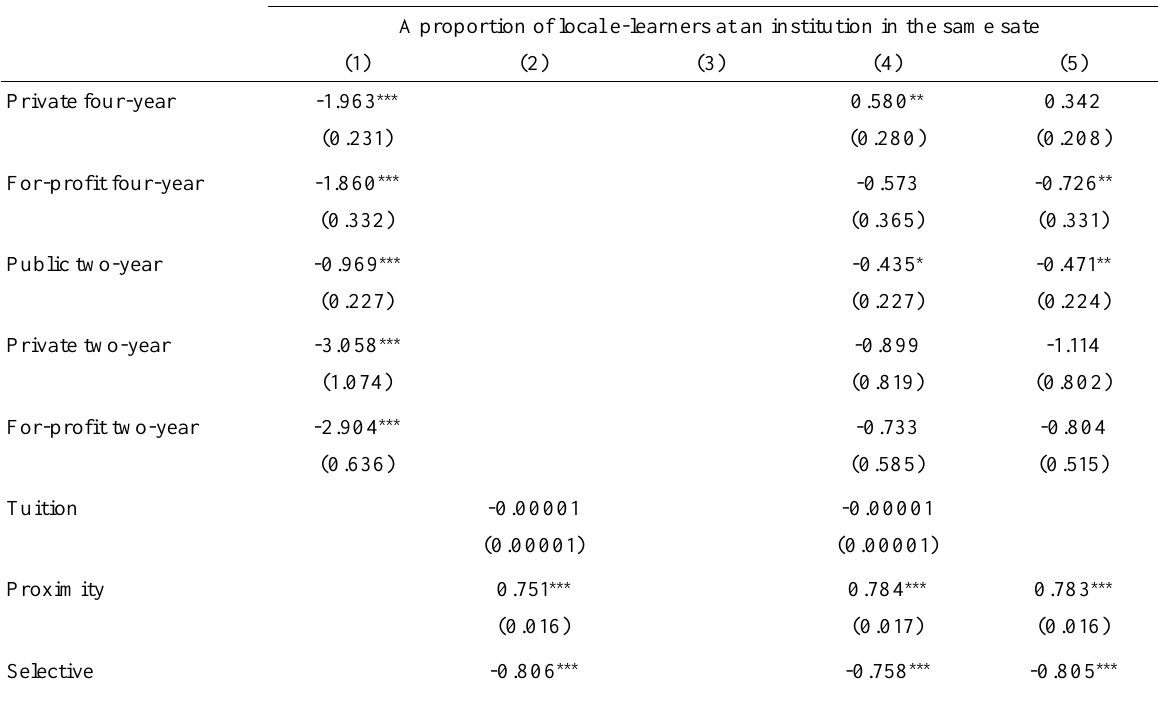
Multiple Regression Models Explaining In-State E-Learner